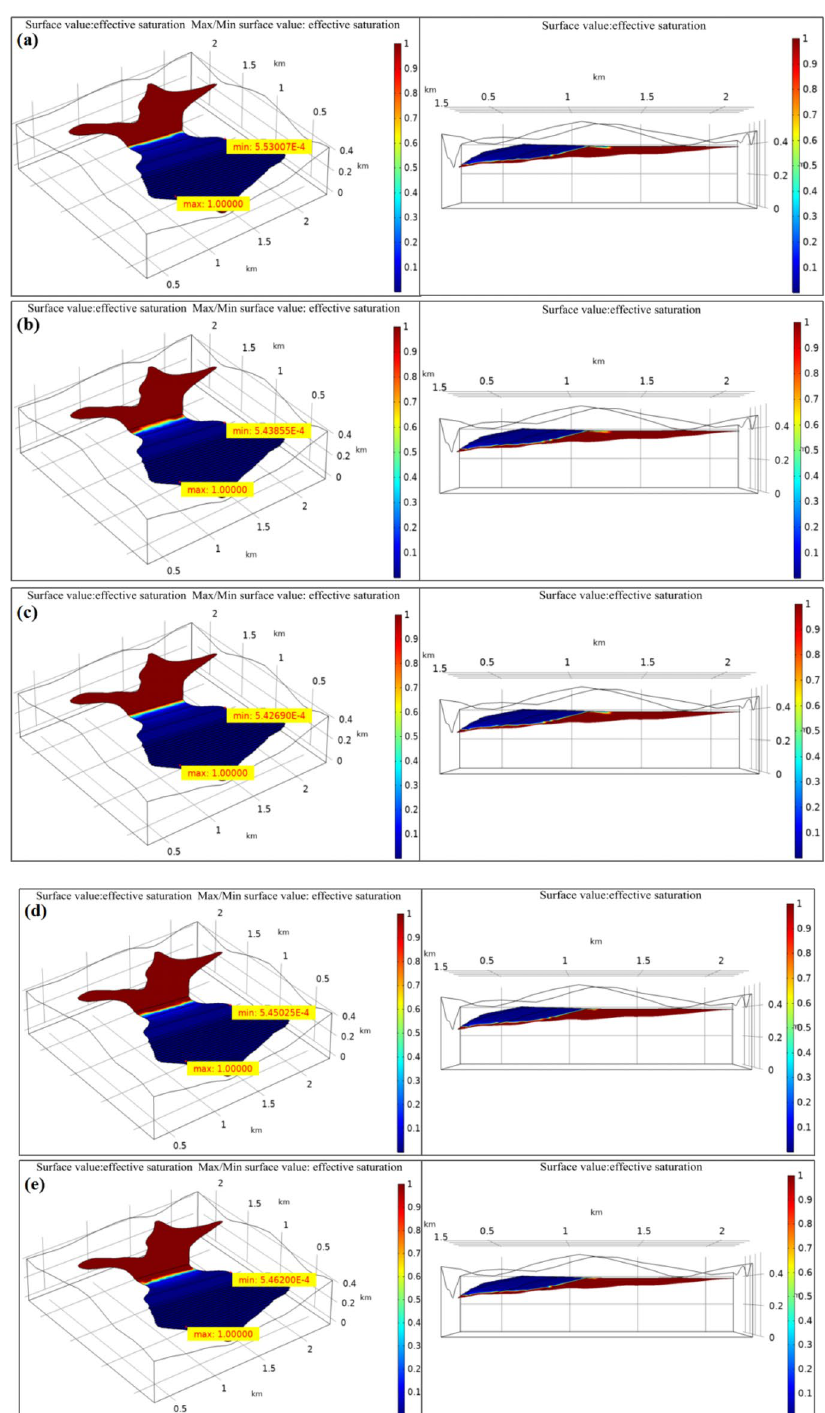
Figure 5. Effective saturation of the tailings dam under different pH values conditions. ( a ) pH = 7 (original sample); ( b ) pH = 3; ( c ) pH = 5; ( d ) pH = 9; ( e ) pH =